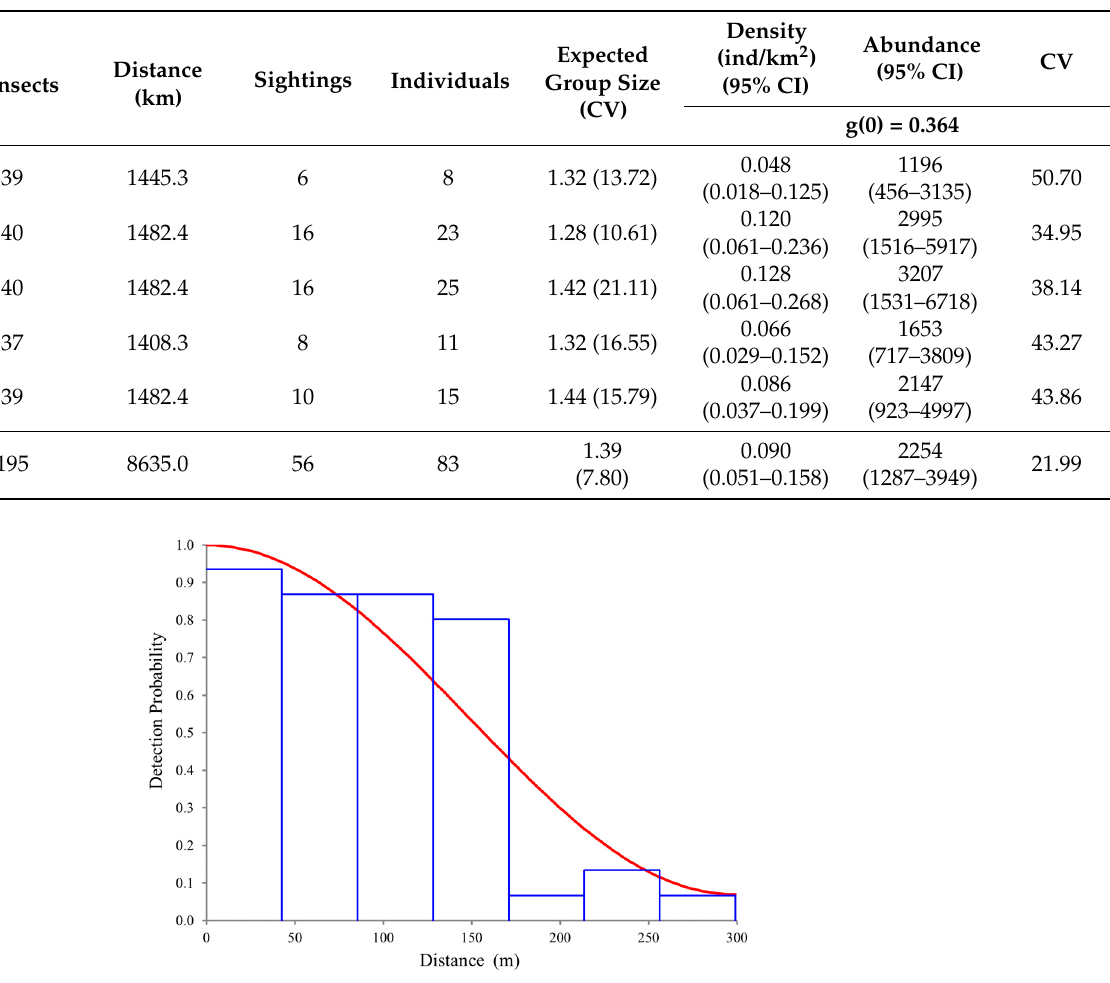
Table 2. Harbour porpoise abundance and density estimates, using g(0) = 0.364 [15], in Portu- gal between 2011 and 2015. Survey effort (number of transects and length), no. of harbour por- poise sightings and individuals, and expected group size. CV, coefficient of variation (%). CI, confidence interval.